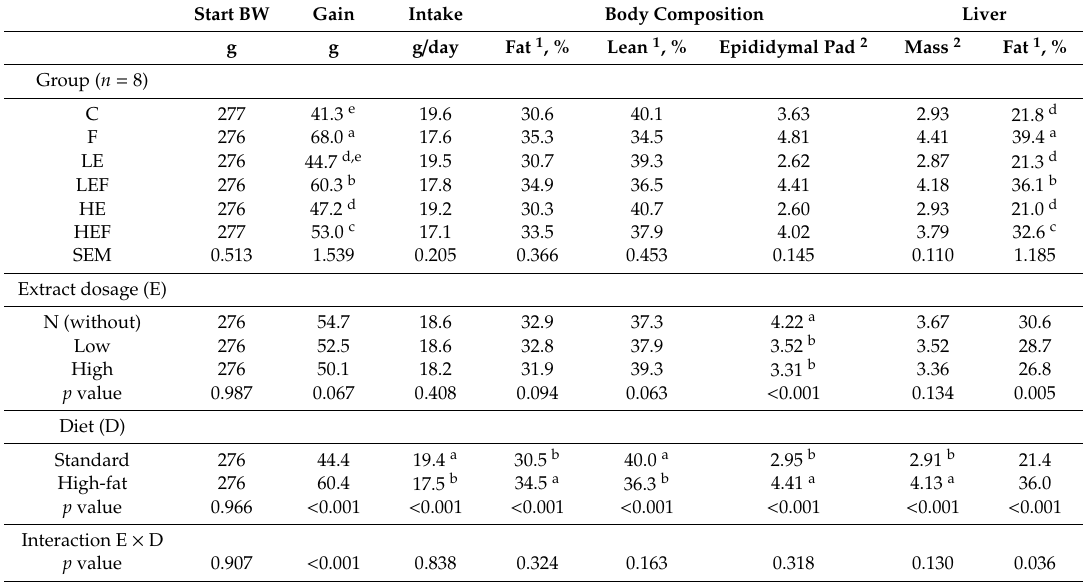
Table 1. The growth parameters, body composition, and liver indices of rats fed the experimental diets *.